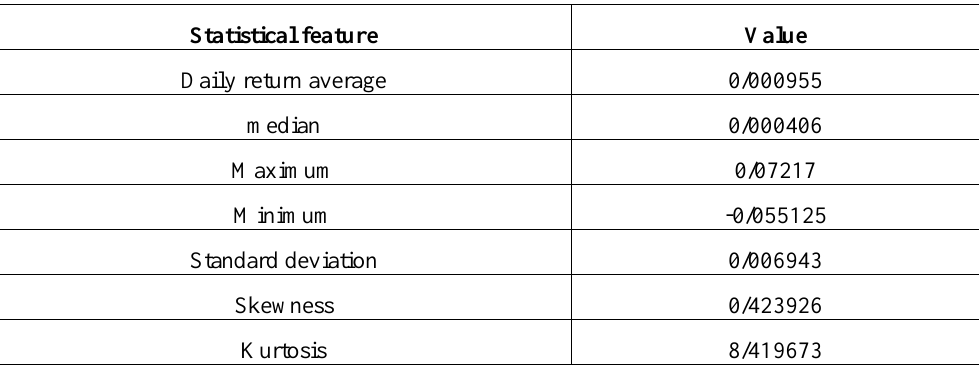
Figure 2. TEPIX index from 2001/3/21 to 2019/3/20 Table 3. The statistical description of TEPIX